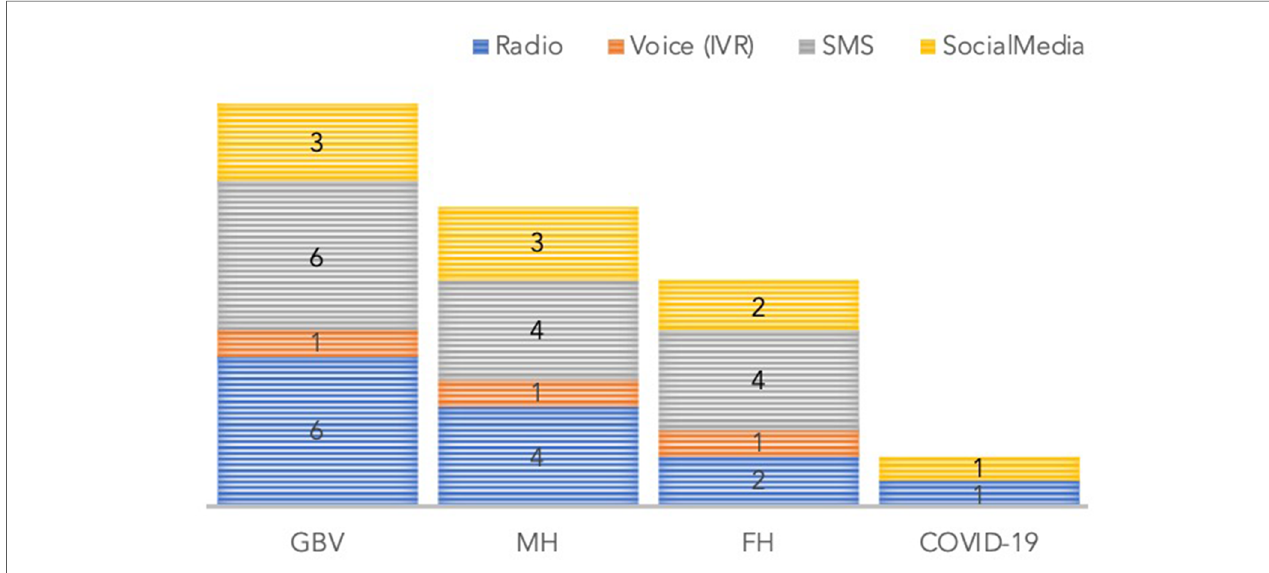
FIGURE 5 Number of messages by health thematic technical area and delivery